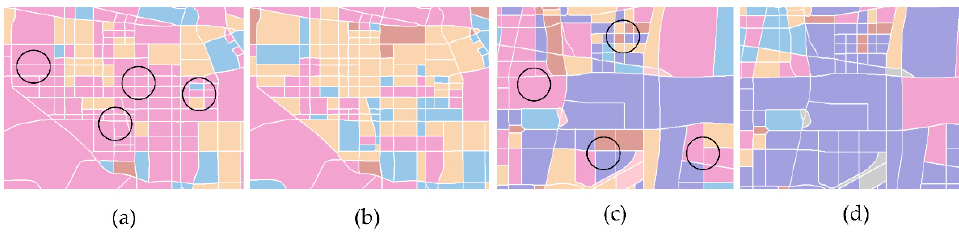
Figure 14. Comparison of LDA model recognition results ( a , c ) and actual functional areas ( b , d ) in the urban center area and suburban area. Note: The urban centers are ( a , b ), while suburbs are ( c , d ).